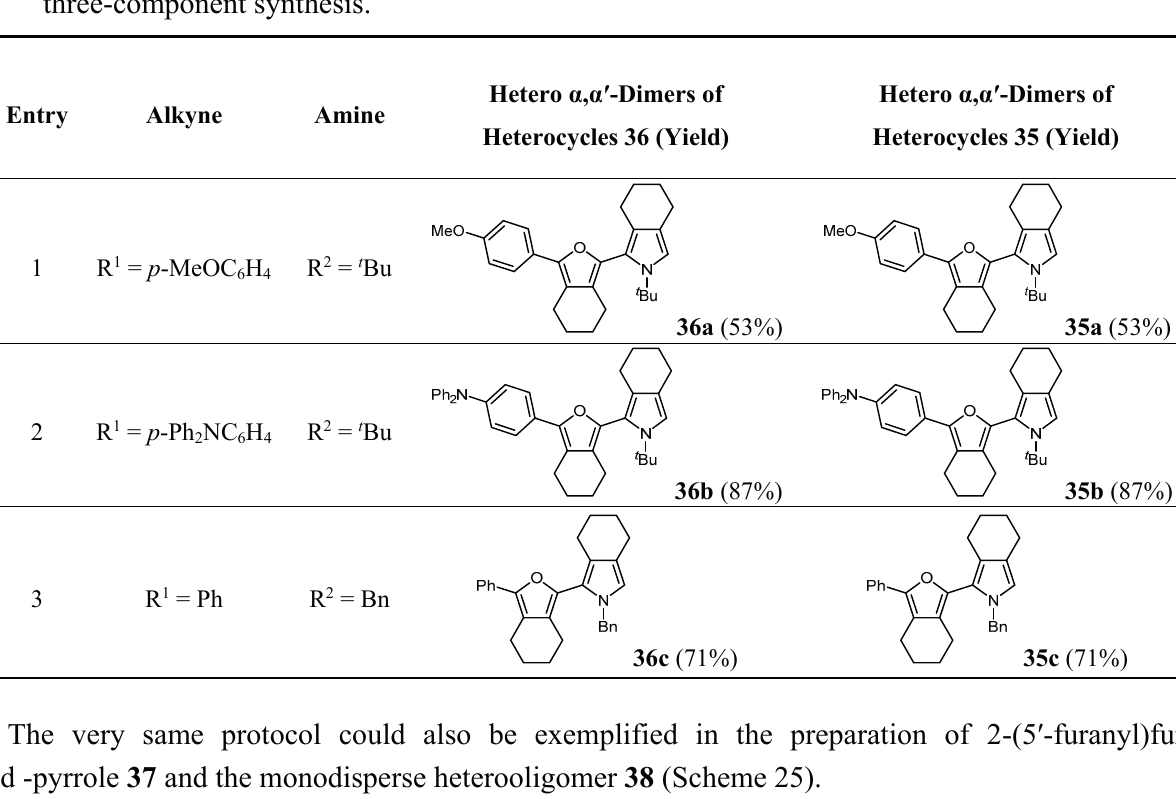
Table 12. Selected hetero α , α′ -dimers of heterocycles 36 via sequentially Pd-Cu-catalyzed three-component